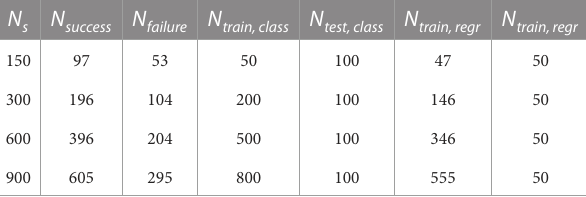
TABLE1 Numberoftrainandtestsamplesofthebinaryclassifiers ( N train,class , N test,class )andtheML-basedROM( N train,regr , N test,regr